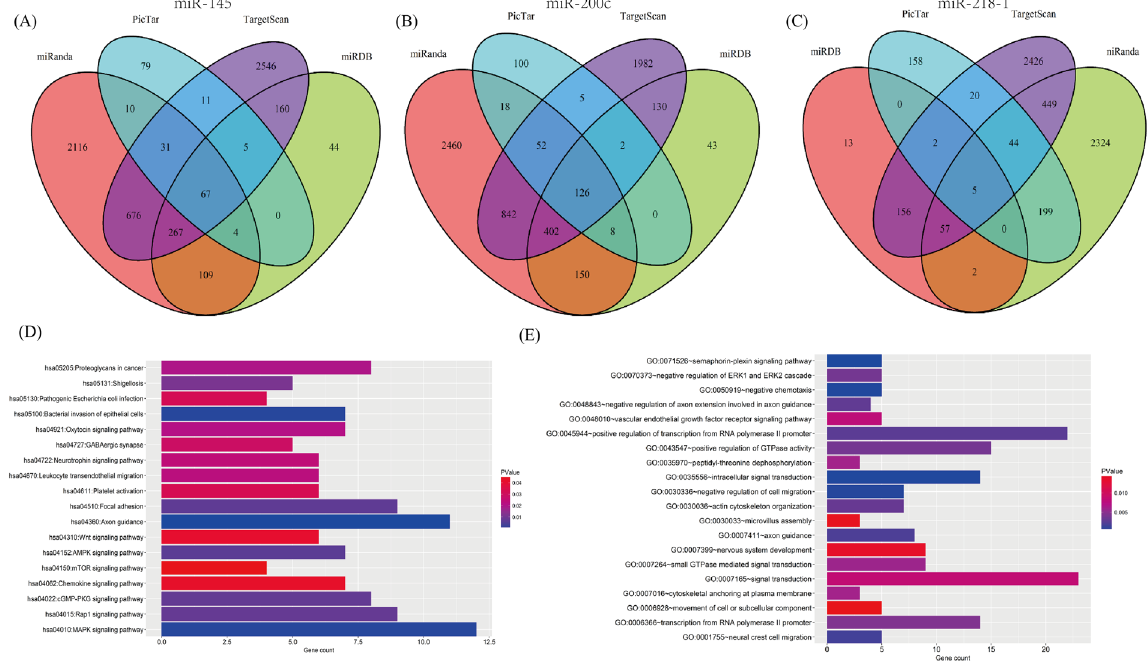
Figure 4. The target gene prediction and function analysis. The overlapping target genes were predicted using TargetScan, miRDB, PicTar, and miRanda online analysis tools. ( A ) miRNA-145; ( B ) miRNA-200c; ( C ) miR- 218-1; ( D ) the significant enriched KEGG pathways of target genes; ( E ) the significant enriched GO biological processes of target